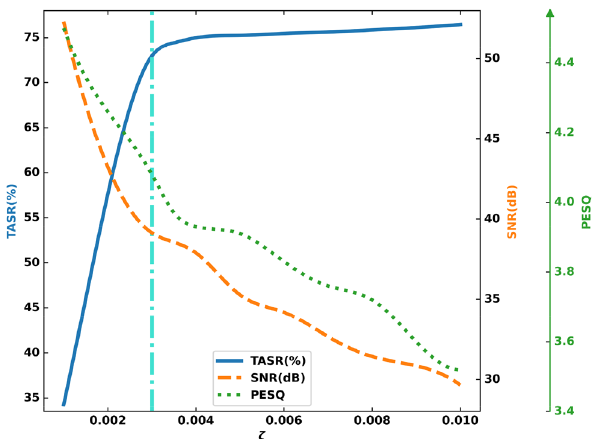
Fig. 7 Parametersensitivitywithrespectto ζ onCSIwith x-vector asthe speaker recognition model. The vertical line indicates the performance with ζ (cid:2) 0.003. λ and d are fixed to 0.005 and L /3, respectively